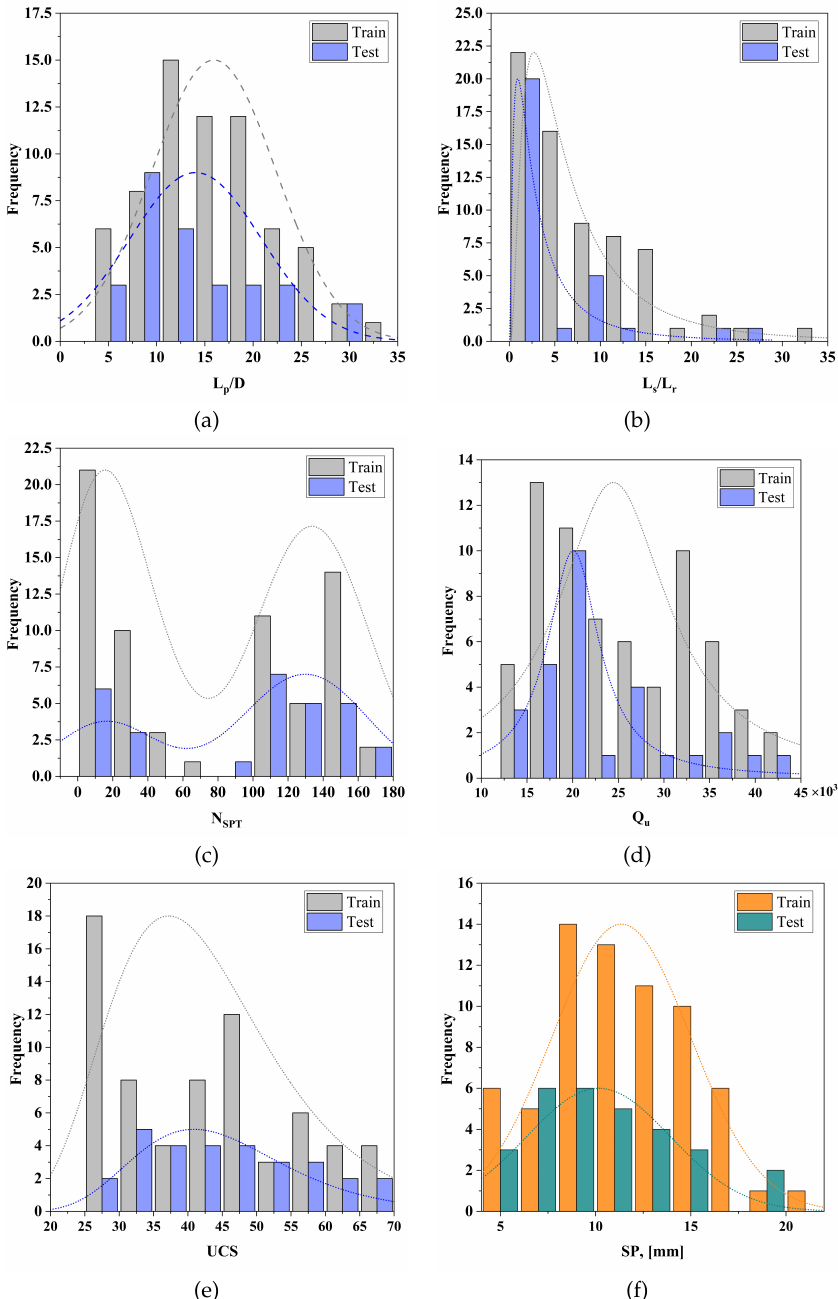
Fig. 2. The dataset histogram figure for the training and testing phases: (a) L p /D (Normal distribution); (b) L s /L r (Lognormal distribution); (c) N SPT (Kernel smooth distribution); (d) Q u (Lorentz distribution); (e) UCS (Lognormal distribution); (f) SP (Normal